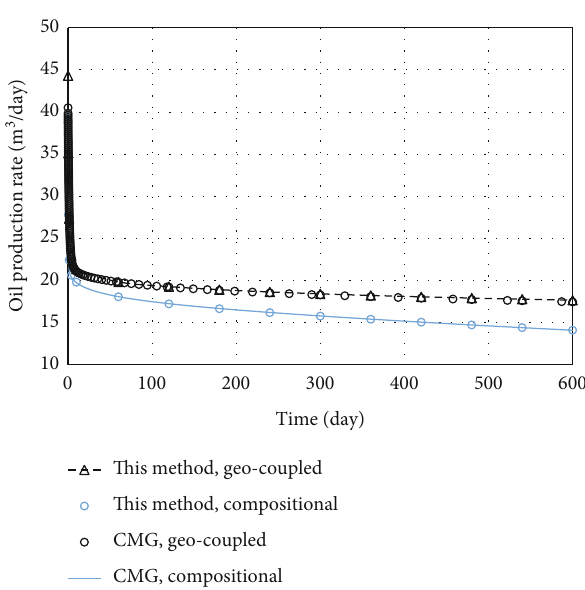
Figure 4: Comparison of oil production rate for Case